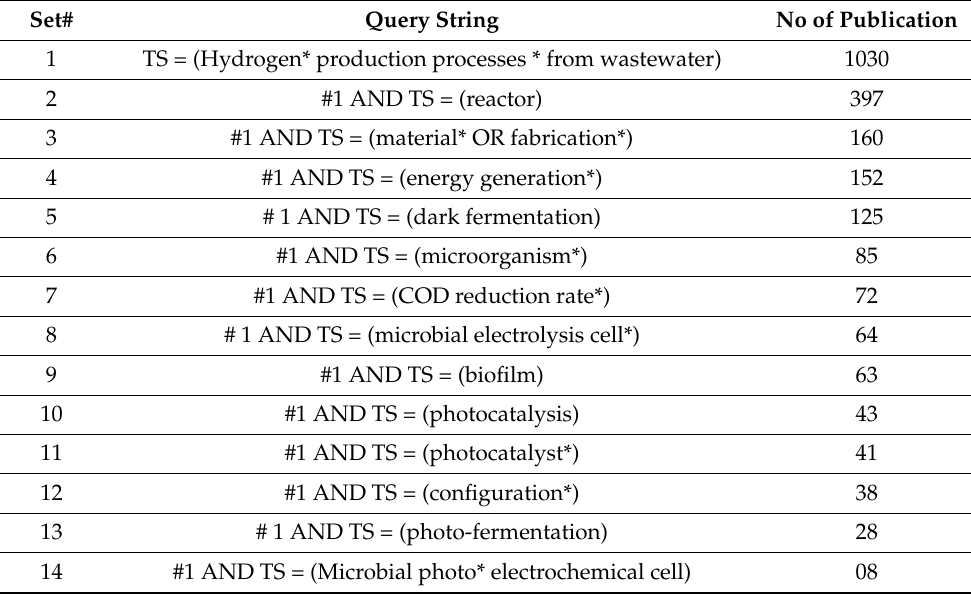
Table 1. Publication results for the different search query strings used in this